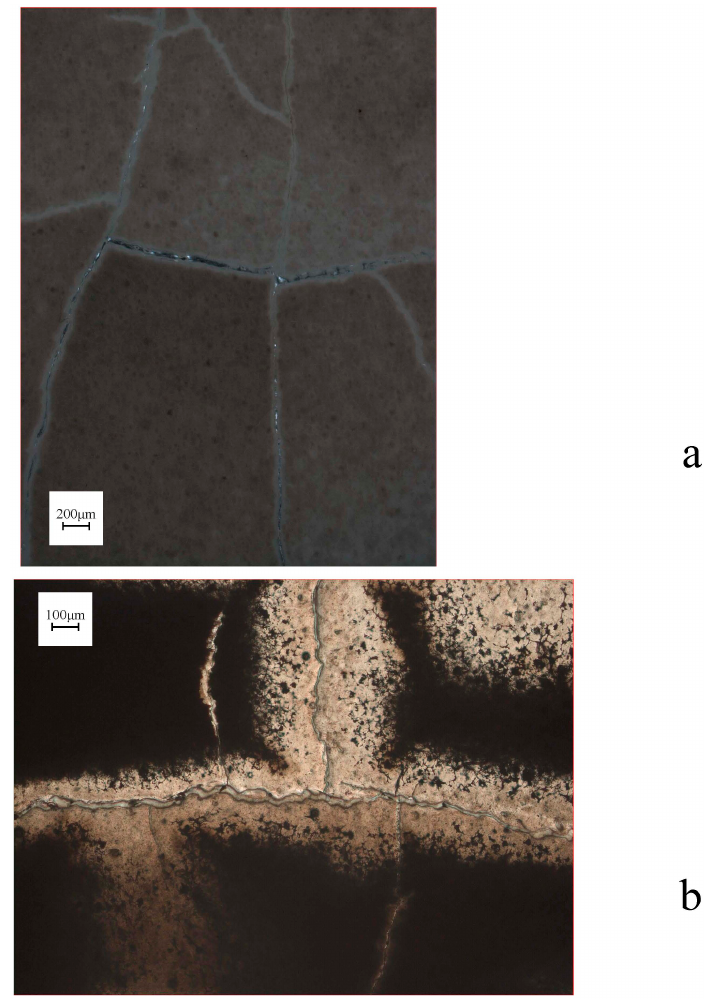
Figure 10. Measured reaction-induced vertical stress resulting from the hydration of periclase (MgO) at 165 °C and 17 MPa fluid pressure. The stress given is the effective stress.